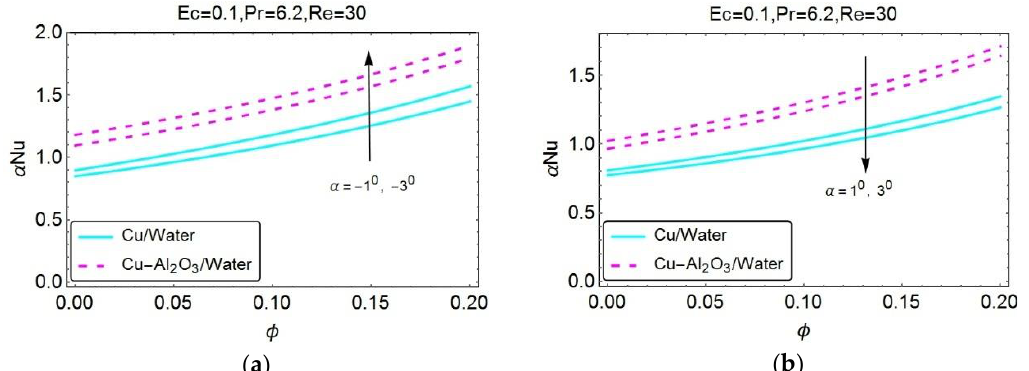
Figure 10. Stimulus of α on αNu: ( a ) convergent case and ( b ) divergent channel. Energies 2020 , 13 , x; doi: FOR PEER REVIEW